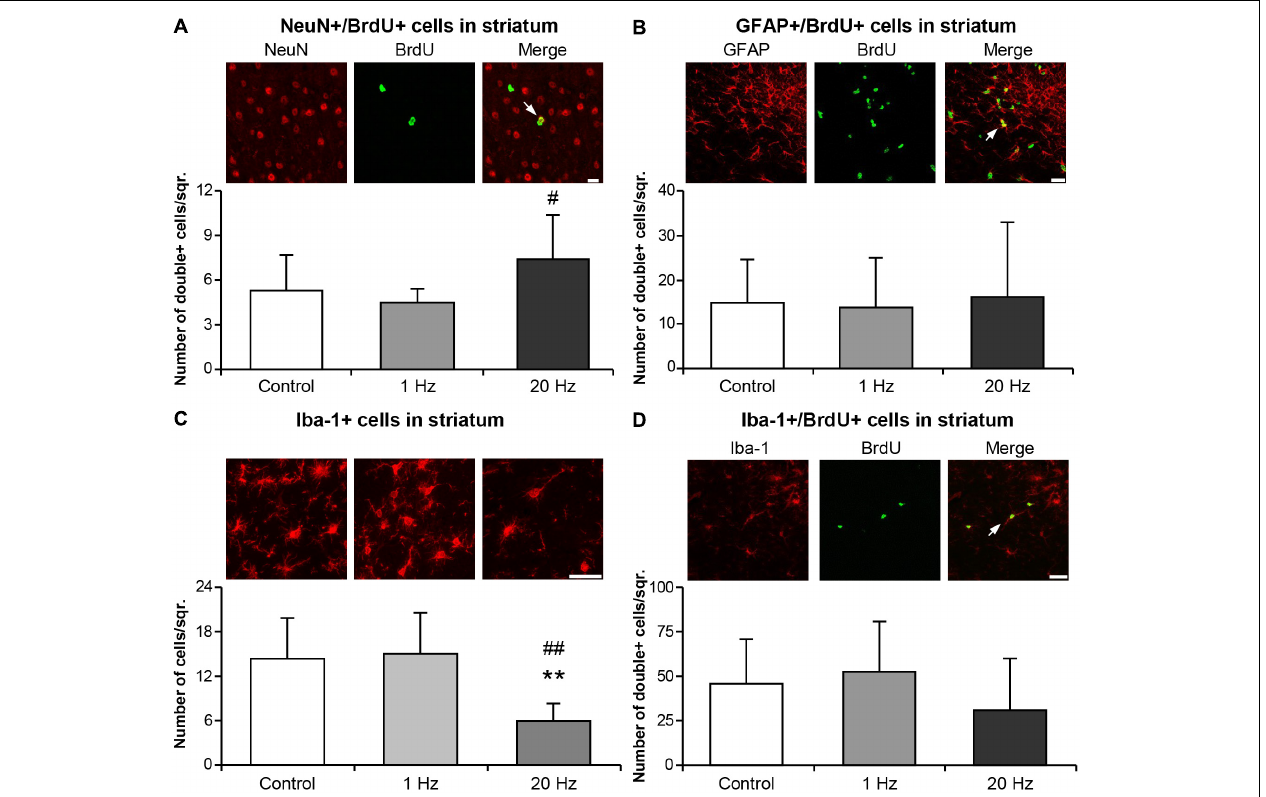
FIGURE 7 | Neurogenesis was induced and Iba-1+ microglial activation was inhibited by 20 Hz rTMS. Post-ischemic cell proliferation was assessed by 5-Bromo-2 (cid:48) -deoxyuridine (BrdU) immunostaining in the ischemic striatum. Co-expressions of BrdU and NeuN (A) , GFAP (B) , and Iba-1 (D) , and microglial activation (C) were evaluated from animals subjected to 30 min ischemia followed by 42 days reperfusion. Data were evaluated by one-way ANOVA followed by LSD tests. Data are presented as mean ± SD values ( n = 7–8 mice/group). ∗∗ p < 0.01 compared with control group and ## p < 0.01/ # p < 0.05 compared with 1 Hz rTMS. White arrows indicate double immunopositive stainings. Scale bar is 100 µ m (A,D) 50 µ m (B,C)